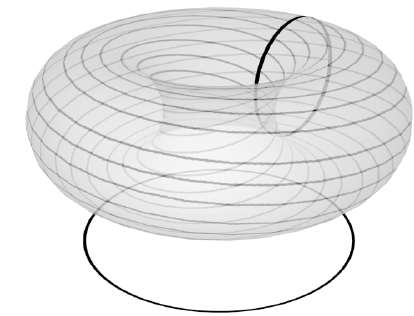
Figure 1. The simplest suspension of a circle transformation over S 1 . Bold circles represent the fiber and base